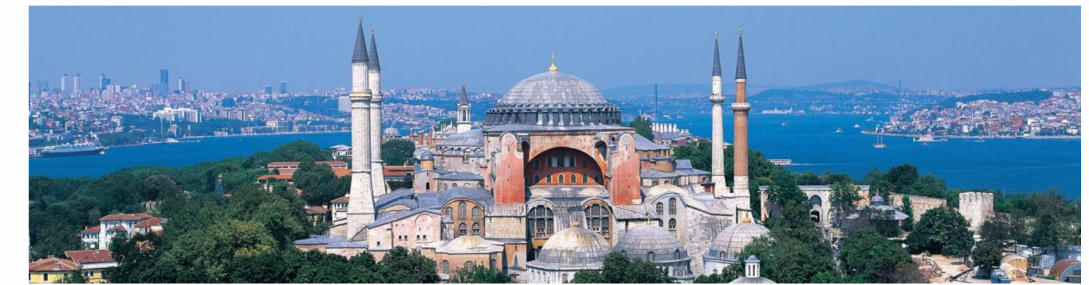
Figure 5. Exterior view of Hagia Sophia